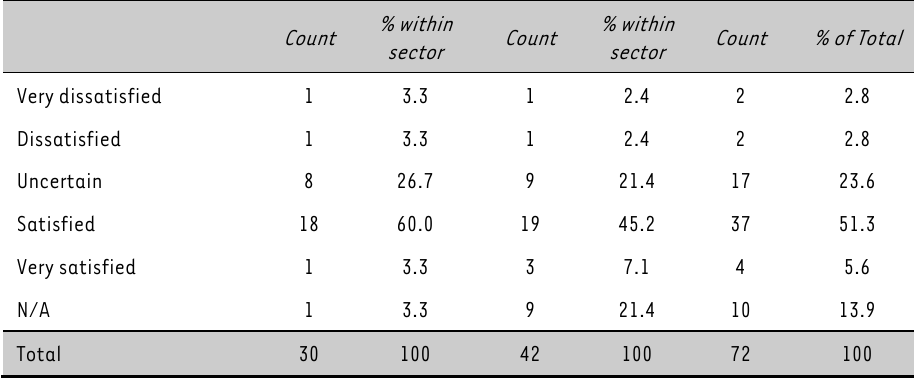
Level of satisfaction with the quality of the provided service by sector